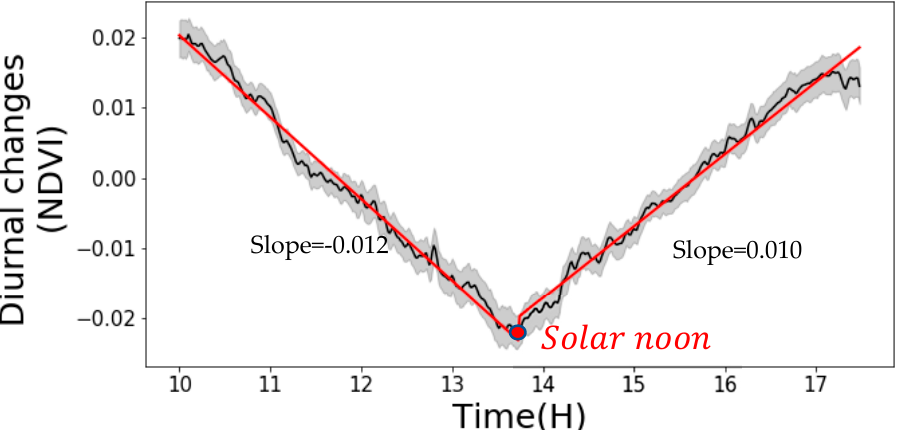
Figure 8. The diurnal changes of NDVI summarized from 31 days and six experimental plots. The x-axis is the diurnal time in a unit of hour. The y-axis is the diurnal NDVI changes. The black line is the mean diurnal NDVI adjustment value. The shaded area is the 95% confidence interval. The red line is the 1st order piecewise fitted result for the mean diurnal NDVI adjustment value.